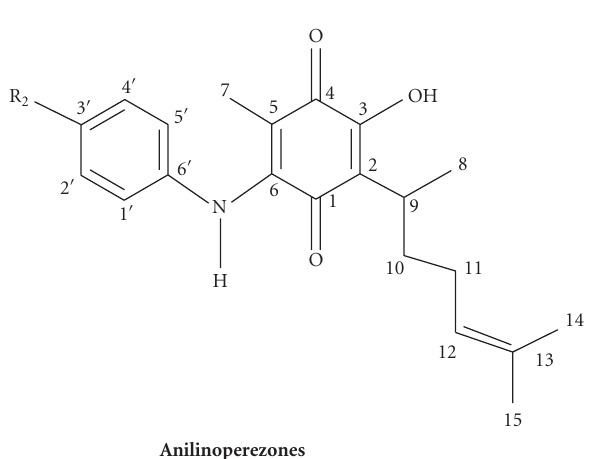
Scheme 6: Structures of naphthoquinones and perezone.